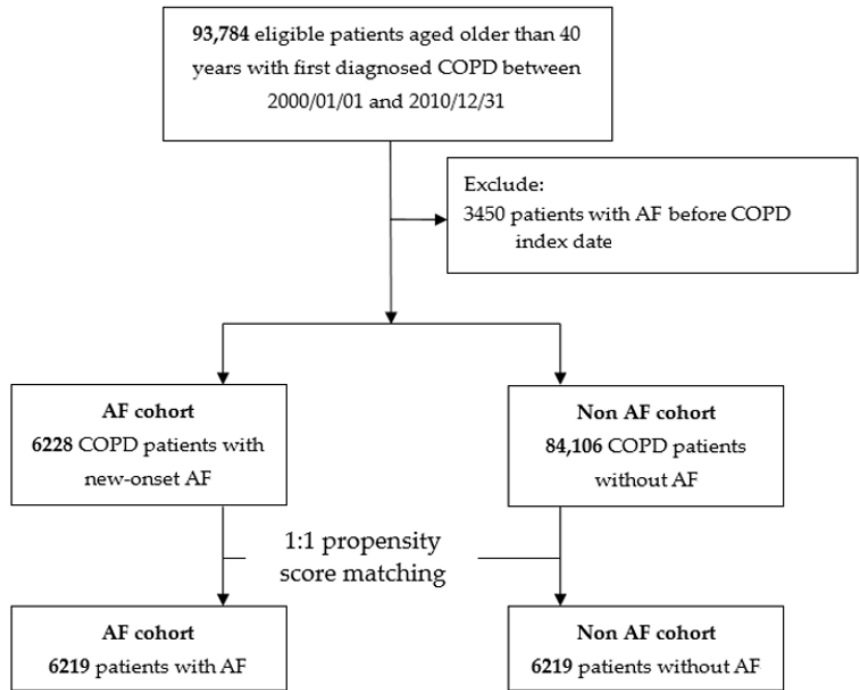
Figure 1. Study flow chart: a population-based cohort study.